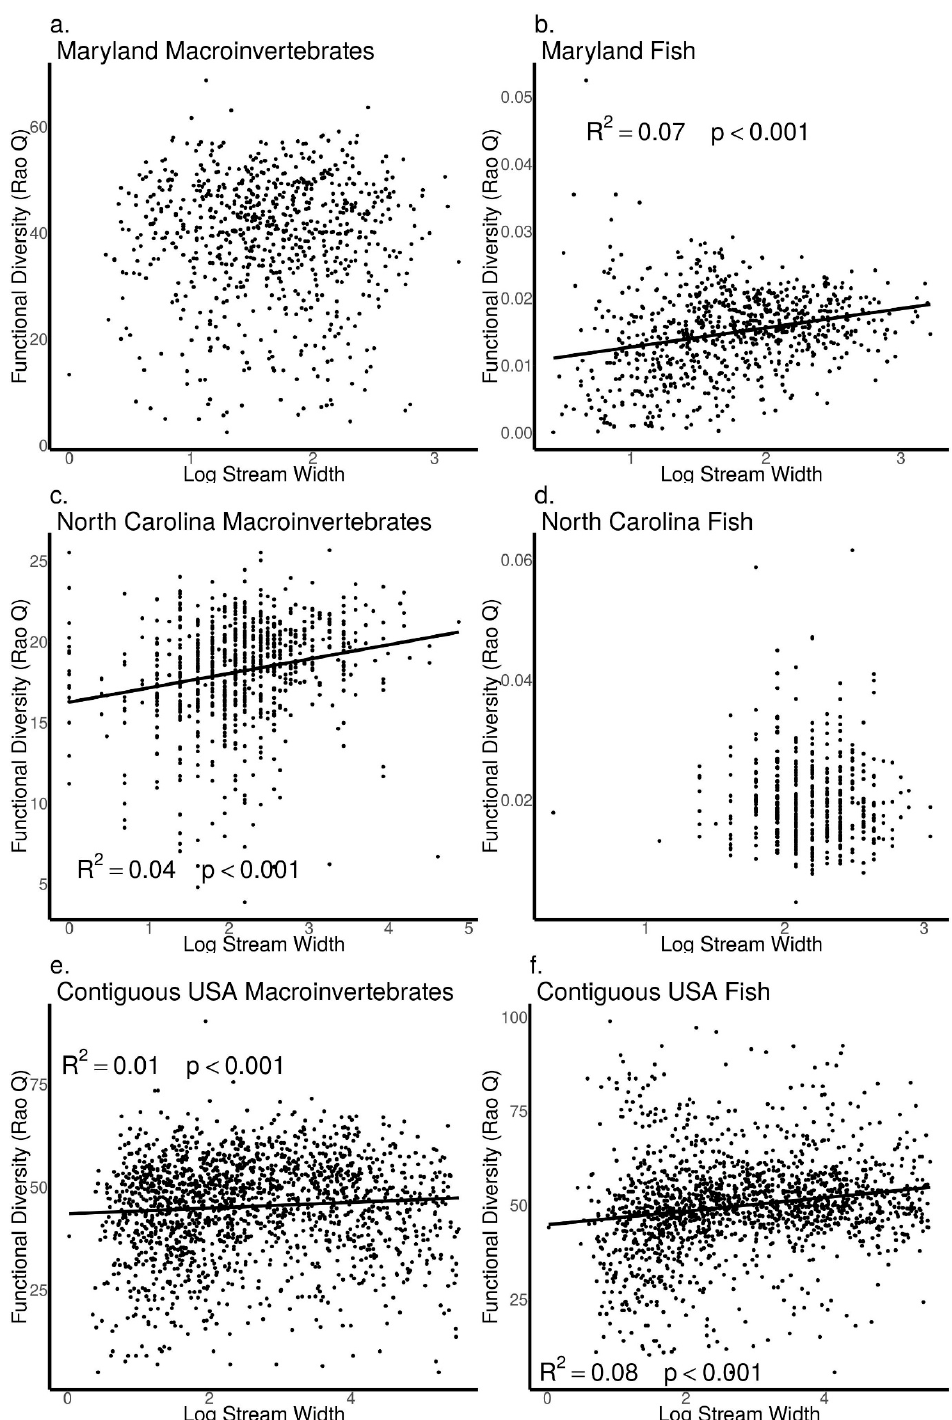
Figure 11. Relationship between functional diversity (Rao Q) and stream width (log+1 transformed) for macroinvertebrate ( a , c , e ) and fish ( b , d , f ) communities collected from Maryland (MBSS), North Carolina (NCBMP) and contiguous USA (USEPA). Lines, R 2 and p -values indicate significant positive relationships determined by linear models.